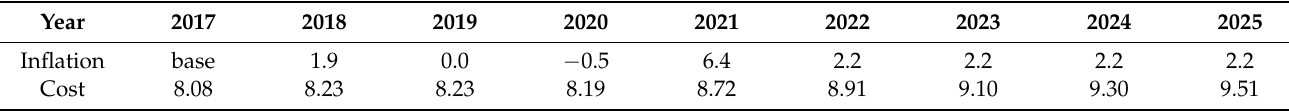
Table 6. Result of installation cost